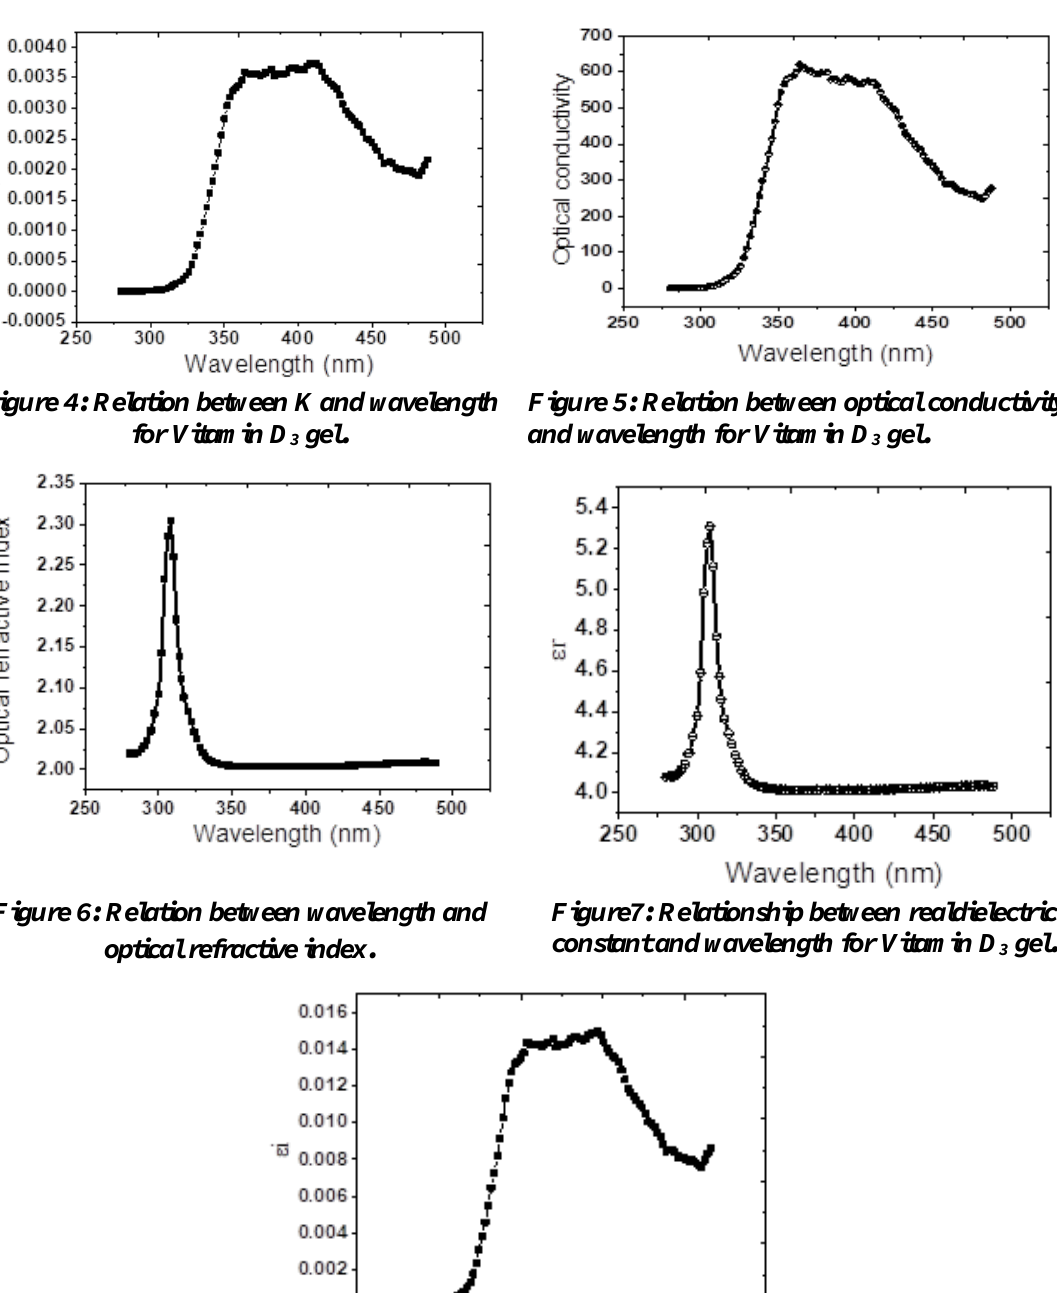
Figure 8: Relationship between imaginary dielectric constant and wavelength for Vitamin D